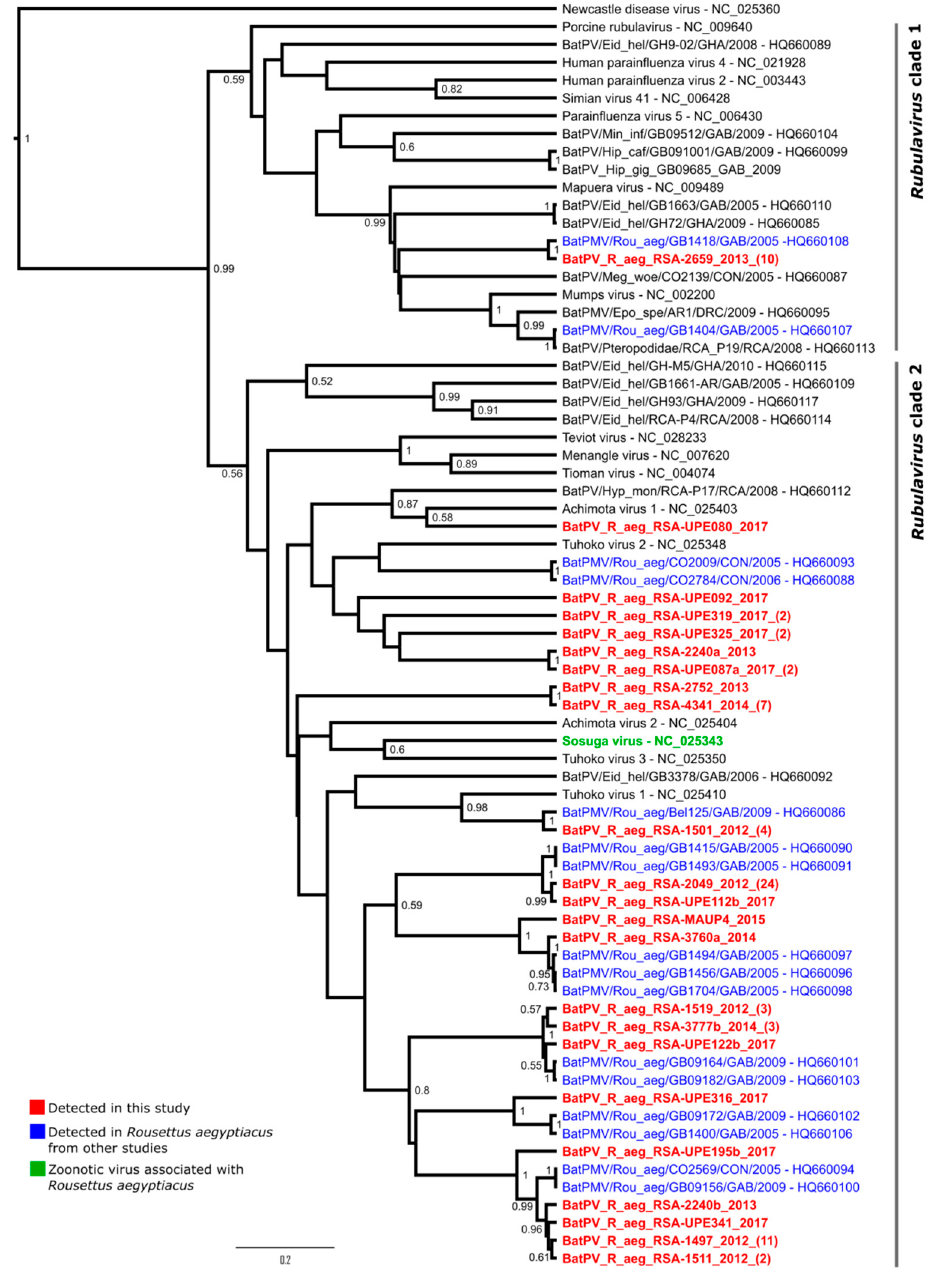
Figure 1. Phylogeny of a partial polymerase ( L ) gene fragment (186 nucleotides) of paramyxoviruses detected in spleen and urine samples using Avula–Rubulavirus genus-specific primers [29]. Bayesian phylogenetic analysis was performed using the Hasegawa-Kishino-Yano model incorporating a gamma distribution and invariant sites (HKY + I + G). Posterior probabilities of >0.5 are indicated at internal nodes. Clade 1 represents the classically known rubulaviruses infecting a range of host species, while clade 2 solely represents bat-borne Rubula - and related viruses. Numbers in brackets at the end of the sequence annotations for viral sequences detected in this study indicated the number of identical sequences detected based on the amino acid sequence for the target region. Newcastle disease virus ( Avulavirus genus) was selected as the outgroup. Refer to Table 1 for accession numbers.